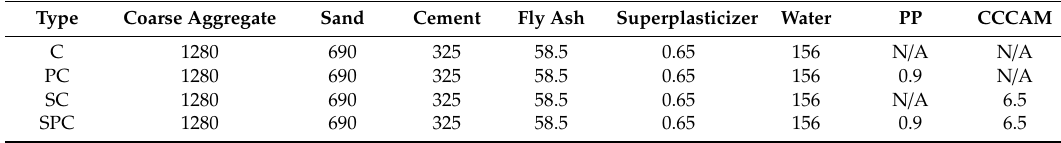
Table 1. The mix proportion of four concrete (Unit: kg / m 3